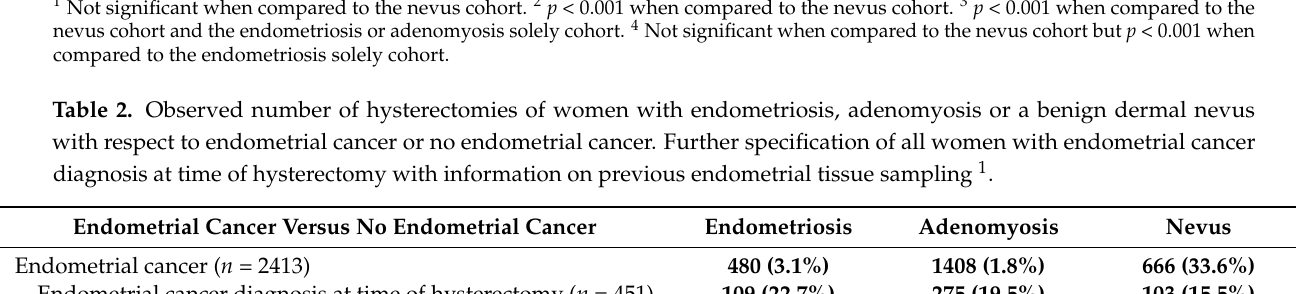
Hysterectomy after endometrial cancer diagnosis (n =